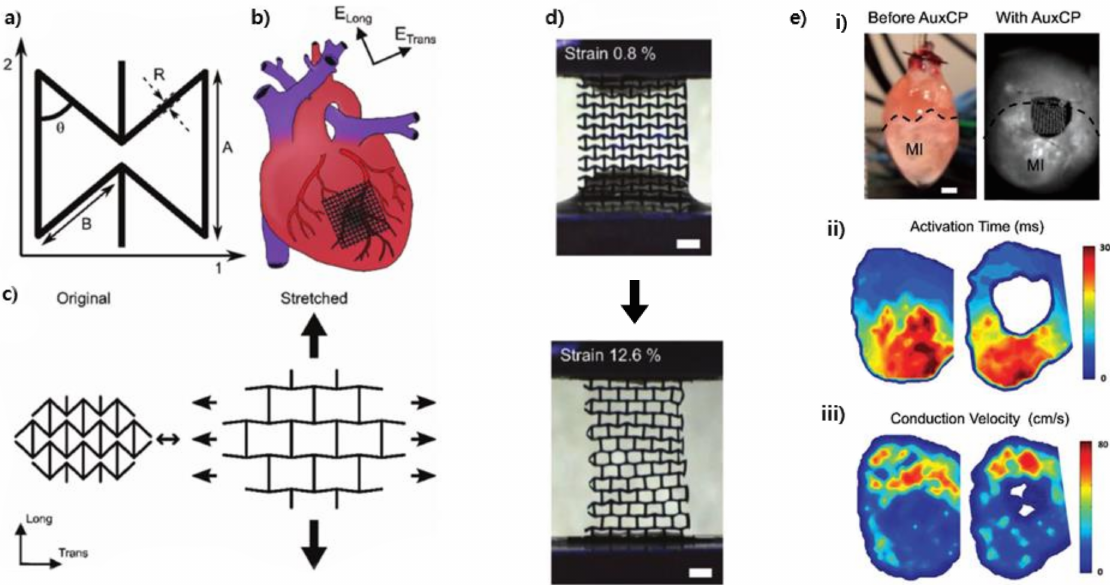
Figure 7. Auxetic cardiac patch for the myocardial infarction treatment. ( a ) Dimension of the re-entrant unit cell. ( b ) Schematic of the treatment using the auxetic cardiac patch (AuxCP). ( c ) Auxetic behavior by the re-entrant unit cells. ( d ) Shape change of the AuxCPs from 0.8% strain to 12.6% strain (scale bar: 1mm), ( e ) ( i ) AuxCP-treated heart (scale: 2 mm), ( ii ) Activation time maps before and after AuxCP (two weeks after treatment), ( iii ) conduction velocity maps before and after AuxCP (two weeks after treatment)